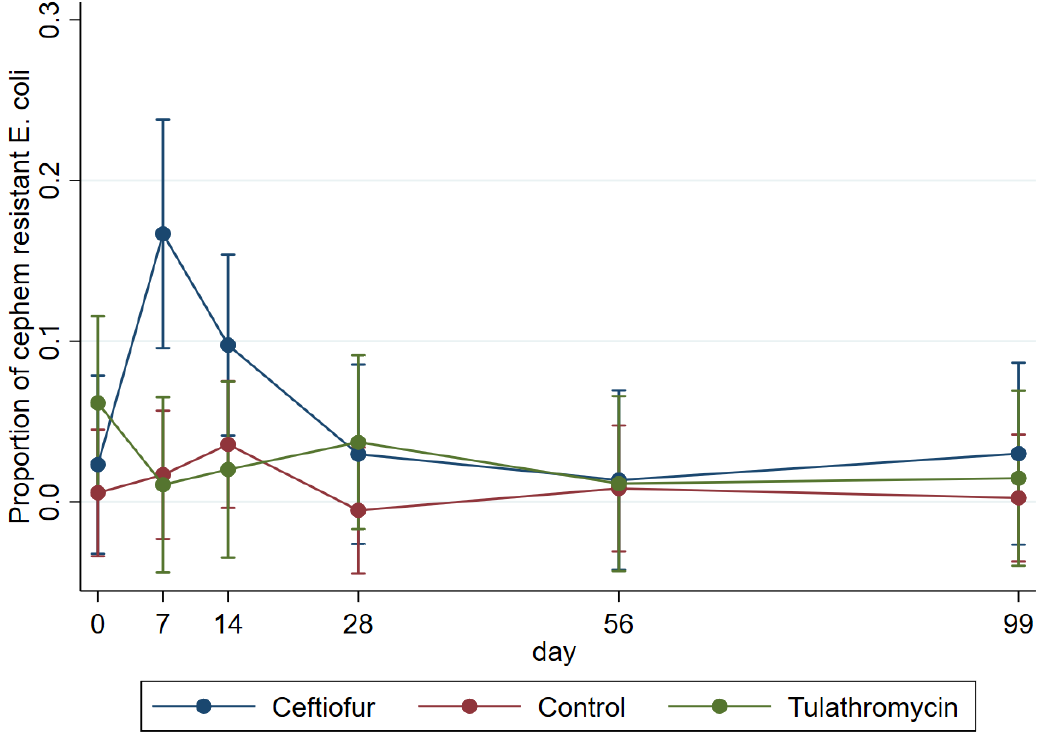
Figure 2. Modeled marginal proportions (i.e., antilog of log 10 difference between MAC and MCef) of 3GC-resistant E. coli over the total E. coli population recovered from fecal samples before (Day 0) and after (Days 7–99) treatment. after (Days 7–99)